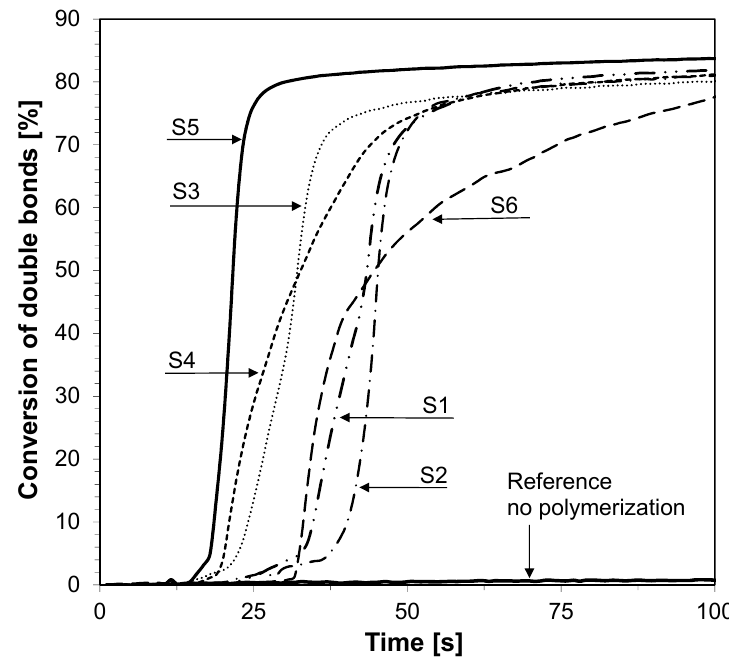
Figure 8. Polymerization profiles of TEGDVE (vinyl function conversion vs irradiation time) upon exposure to the LED@365 nm (95 mW/cm 2 ) under laminate in the presence of different photoinitiating systems based on diphenyliodonium hexafluorophosphate (HIP, 1%) and 2-amino-4,6-diphenyl- pyridine-3-carbonitrile derivatives. The irradiation starts at t = 10 s.